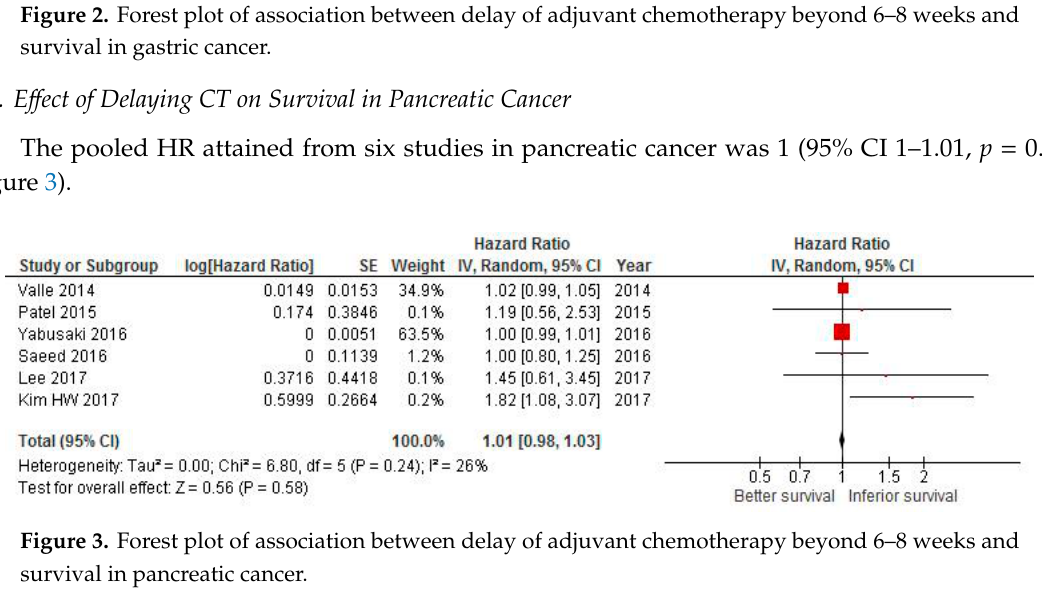
Figure 3. Forest plot of association between delay of adjuvant chemotherapy beyond 6–8 weeks and survival in pancreatic cancer.